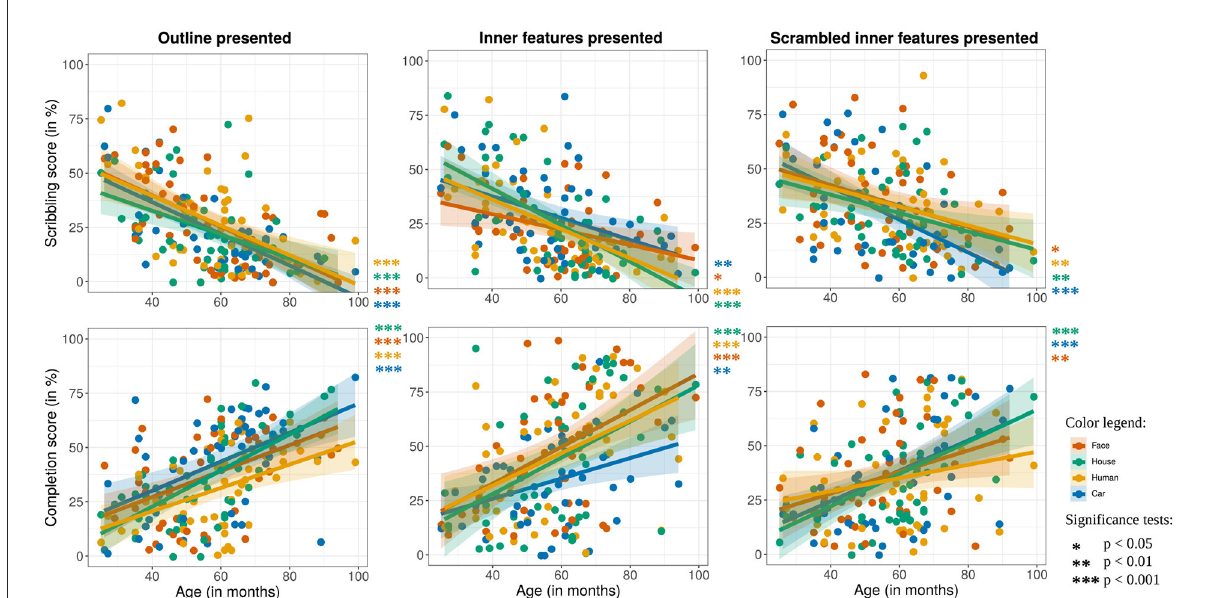
FIGURE5 How scribbling (top) and completion score (bottom) develop across the age of the children, separately displayed for drawings where the outline (left) , the inner features (middle) , and the scrambled features (right) were presented. The colors refer to the category of the presented stimuli. Each point represents the average score of all ratings of one child drawing, and the lines show linear model fits. Reproduced with permission from Philippsen et al.